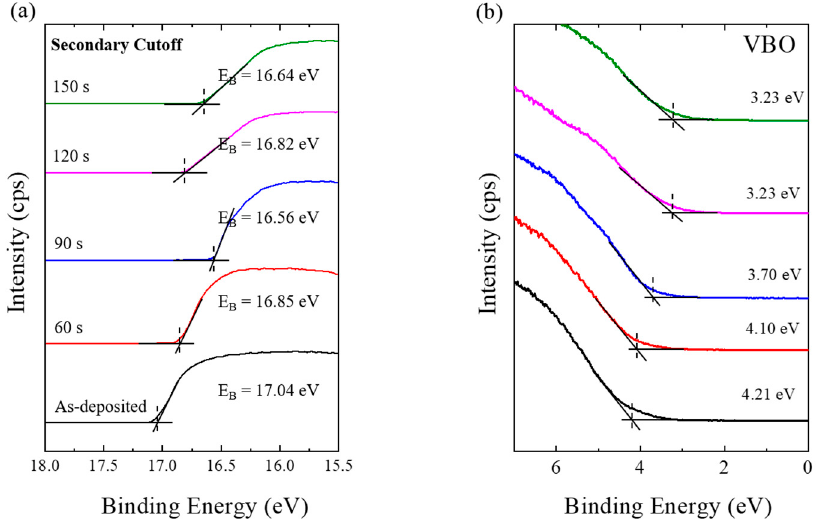
Figure 1. UPS measurements of Zn 0.6 Sn 0.4 O thin films exposed to different O 2 plasma treatment times. ( a ) the higher binding energy edge of the secondary electrons and ( b ) the valence structure.